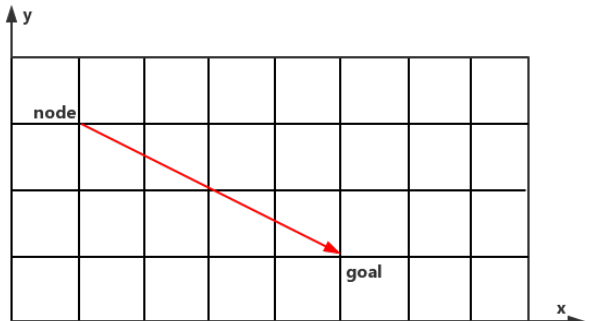
Figure 8. From node to